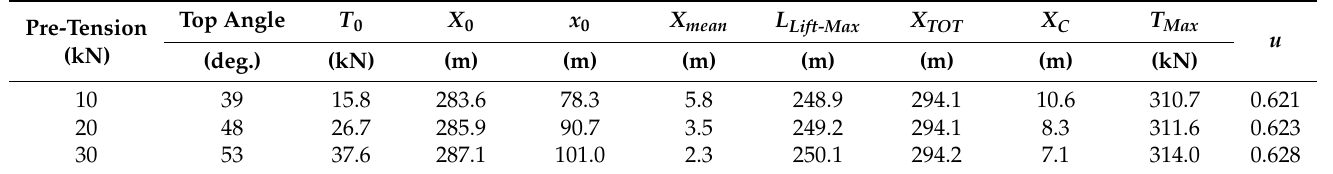
Table 16. Case 2, Increased Diameter: D1 = 32 mm, D2 = 120 mm, D 3 = 54 mm, quasi-static